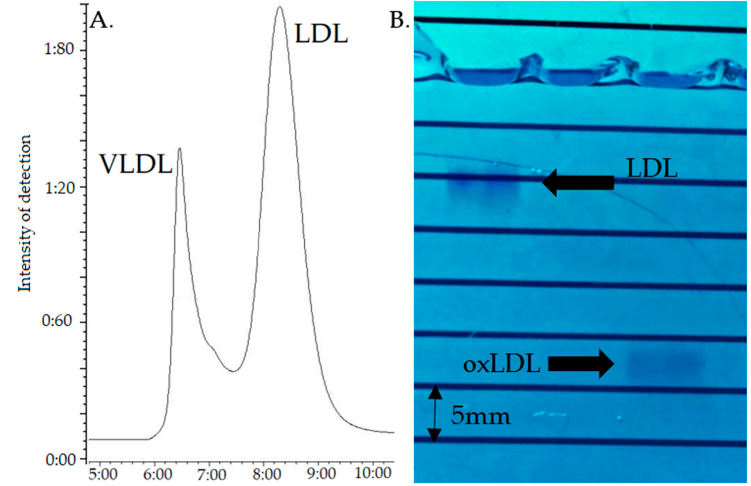
Figure 1. ( A ) Typical GPC chromatogram of the LDL/VLDL extract obtained by selective precipitation from human plasma. ( B ) Migration pattern of LDL (left) and Cu ++ -treated LDL (oxLDL, right) migration on a 0.5% agarose gel electrophoresis, after 60 min running at 70 V. 2.2. OxLDL Internalization in HNCC OxLDL uptake in cancer cells was detected after Red Oil staining. On 93VU-147T cells, we compared our “ home-made ” oxLDL with reference oxLDL: 47.7% of cells showed an uptake with our oxidized LDL against 42.4% with commercially available oxLDL (48 h exposure; Figure 2B,C). Negative control shows 12.2% uptake (Figure 2A) ( home-made ox- LDL vs. negative control, t -test, p = 0.007; reference oxLDL vs. negative control, t -test, p = 0.002). No significant difference was highlighted between our home-made and reference oxLDL ( t -test, p = 0.483).